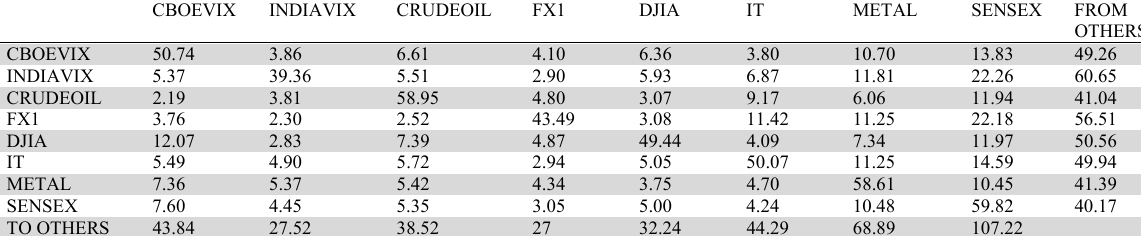
Diebold-Yilmaz Spillover at D3 Scale CBOEVIX